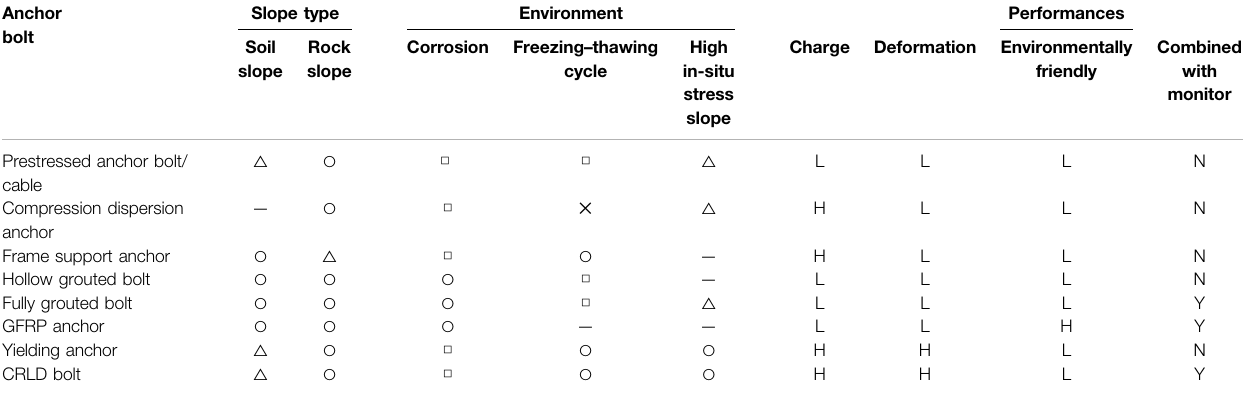
TABLE2| Summaryoftheanchorboltsusedassupportfordifferentkindsofslopesandtheirperformance(Wangetal.,2008;Tangetal.,2012;Zhouetal.,2013;Nieetal., 2014a; Tao et al., 2015; Zhu et al., 2017; Bai et al., 2018; Xiang et al., 2022). Anchor